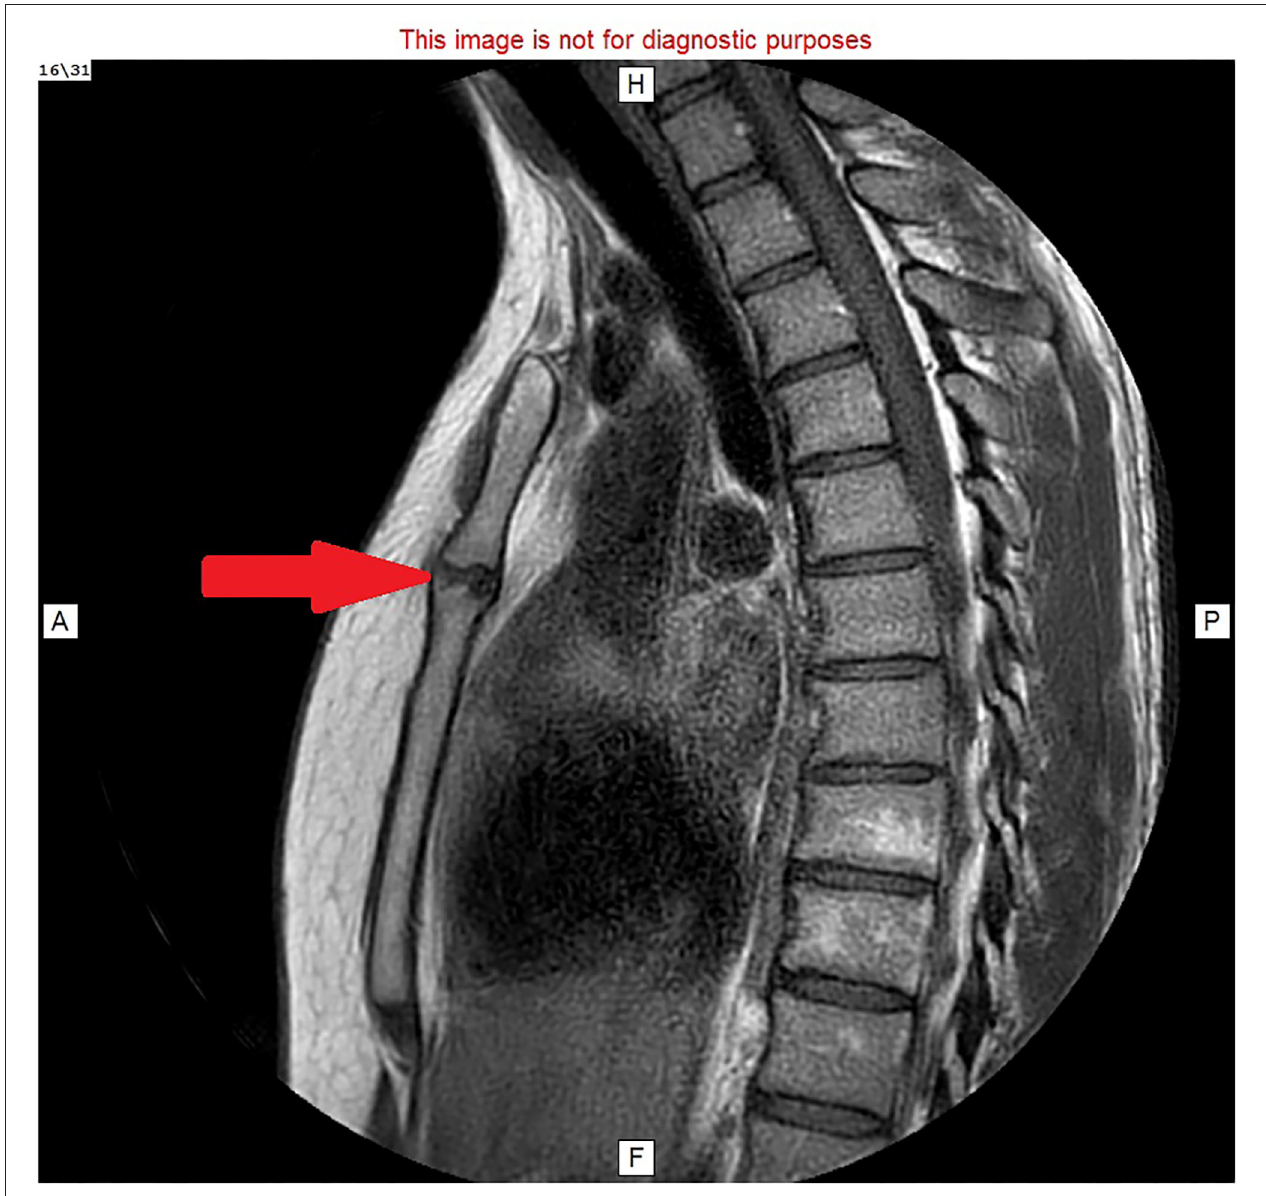
FIGURE 3 | MRI image: T1 with faset and gadolinium contrast, sagittal view, showing hyperemic fluid in the manubriosternal joint (red arrow).